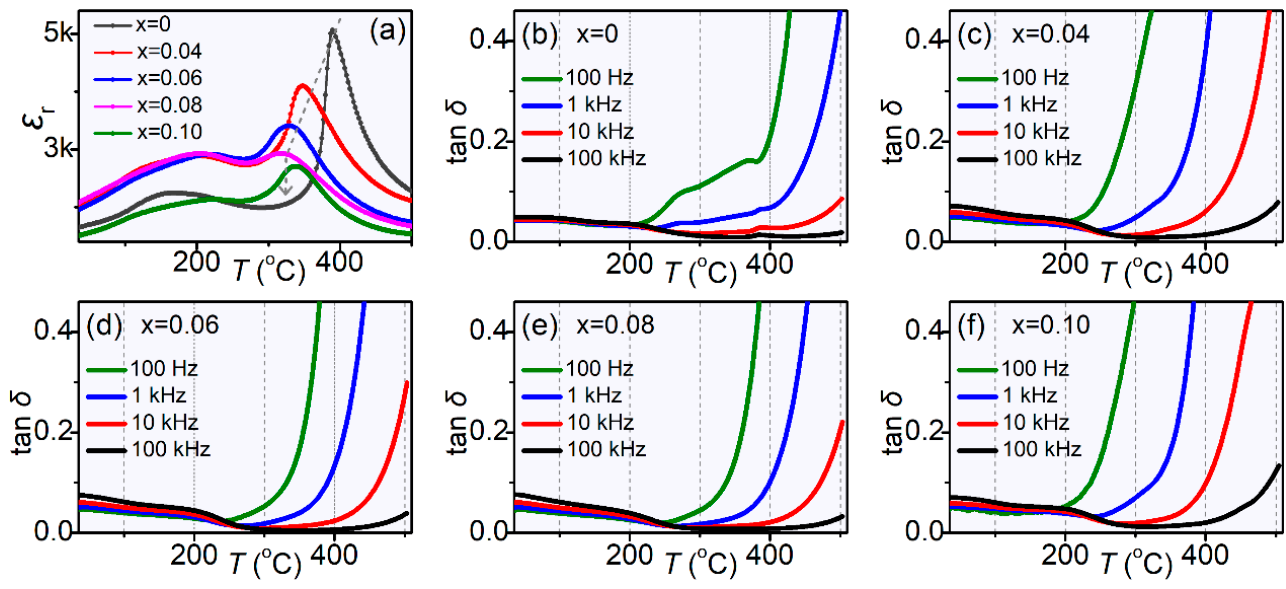
Figure 4. ( a ) Composition-dependent ε r - T curves as a function of x for KNNS x -BNN ceramics. Temperature/frequency dependence of tan δ - T curves of KNNS x -BNN ceramics with ( b ) x = 0, ( c ) x = 0.04, ( d ) x = 0.06, ( e ) x = 0.08 and ( f ) x = 0.10. Table 1. Comparison of grain size, ε r , P r and piezoelectric coefficient d 33 between this system and other fine-grain KNN-based ceramics prepared by the traditional solid-state method.